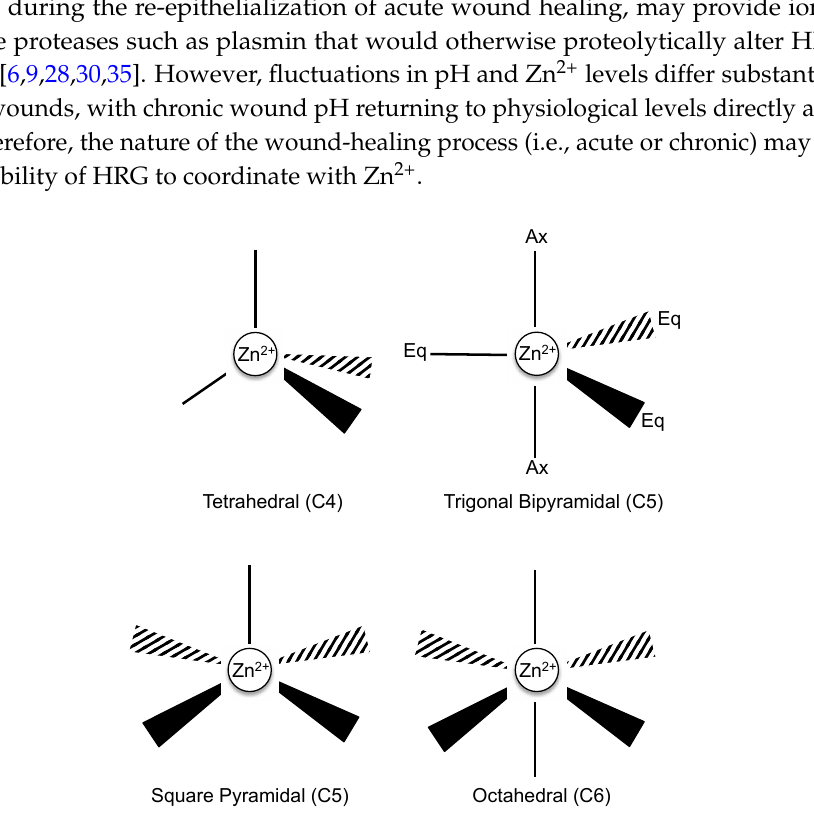
Figure 2. Ideal Zn 2+ coordination geometries. The figure represents the types of ideal Zn 2+ coordination geometries such as tetra (C4), penta (C5) and hexa (C6). The Ax = axial and Eq = equatorial define the ligand donor that participates in accommodating the Zn 2+ ‐ binding site complex. Figure adapted by Patel et al. [29].